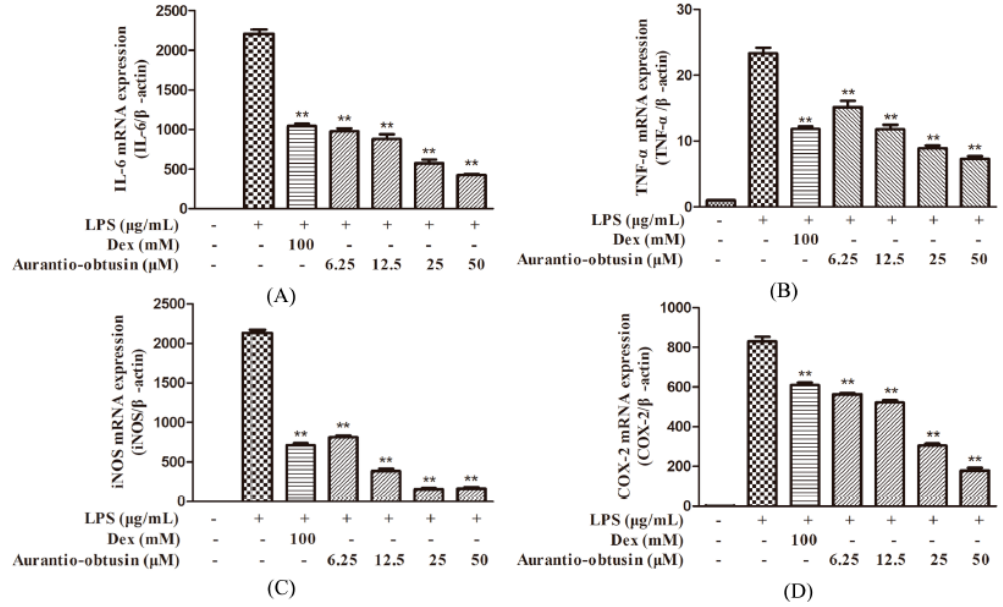
Figure 1. Effect of aurantio-obtusin on LPS-stimulated mRNA expression of IL-6, TNF- α , iNOS, and COX-2. RAW264.7 cells were pre-incubated with various concentrations of aurantio-obtusin (6.25–50 µ M) for 2 h, followed by stimulation with LPS (0.2 µ g/mL) for 24 h. The mRNA expression of IL-6 ( A ), TNF- α ( B ), iNOS ( C ), and COX-2 ( D ) was analyzed using real-time RT-PCR. The data are presented as mean ± SDs ( n = 3). ** p < 0.01 represents significance when compared to LPS-only treated